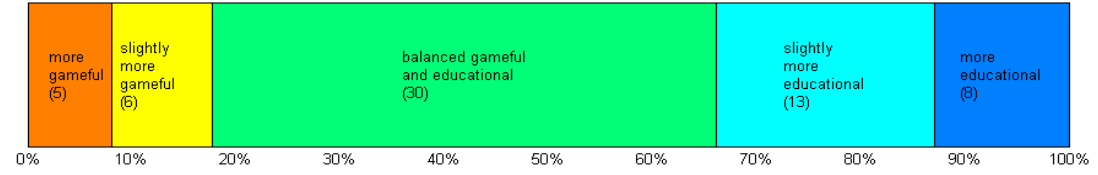
Figure 9. Perception of balance between game and education in the game.